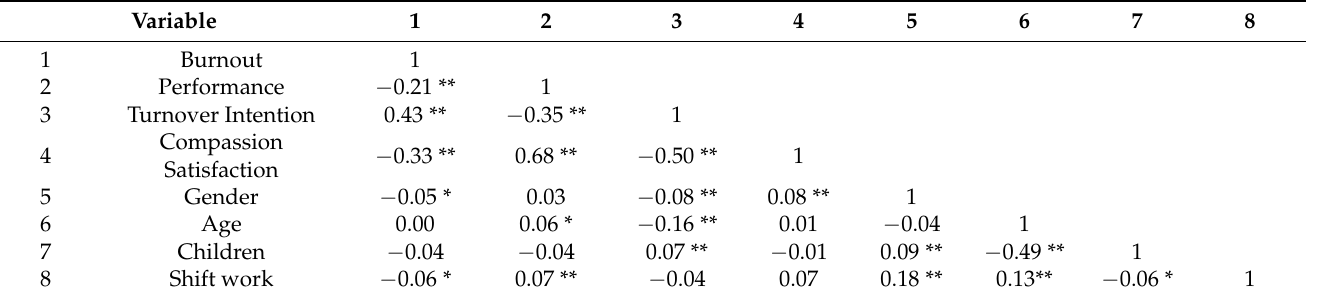
Table 1. Correlation between